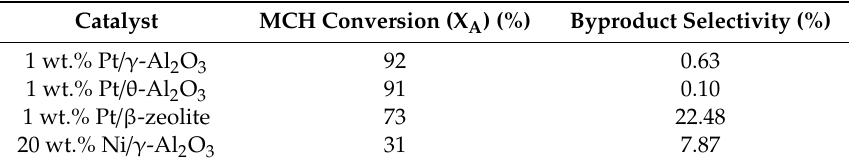
Table 5. Catalyst comparison by Usman et al. (Adapted from